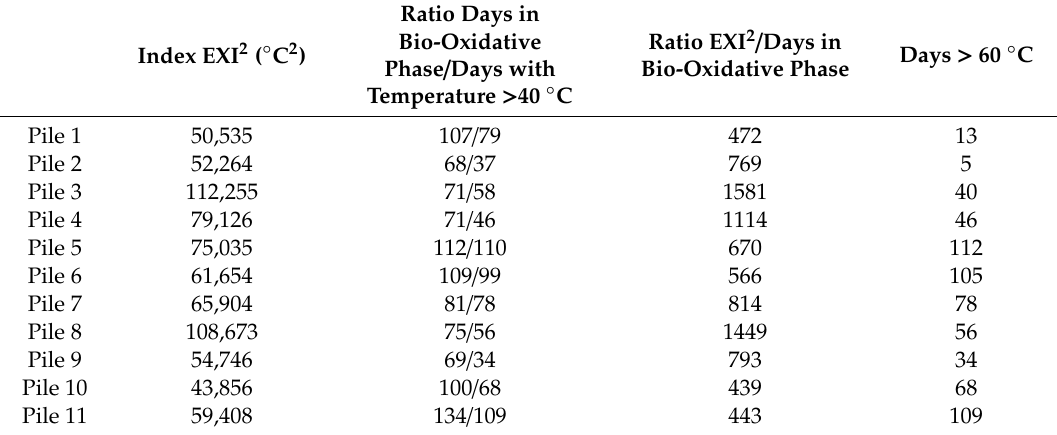
EXI 2 : quadratic exothermic index (quadratic sum of the daily di ff erence between the average temperature of the pile and the ambient temperature). Piles 1–7, mainly constituted by sewage sludge; Piles 8–11, mainly constituted by agri-food